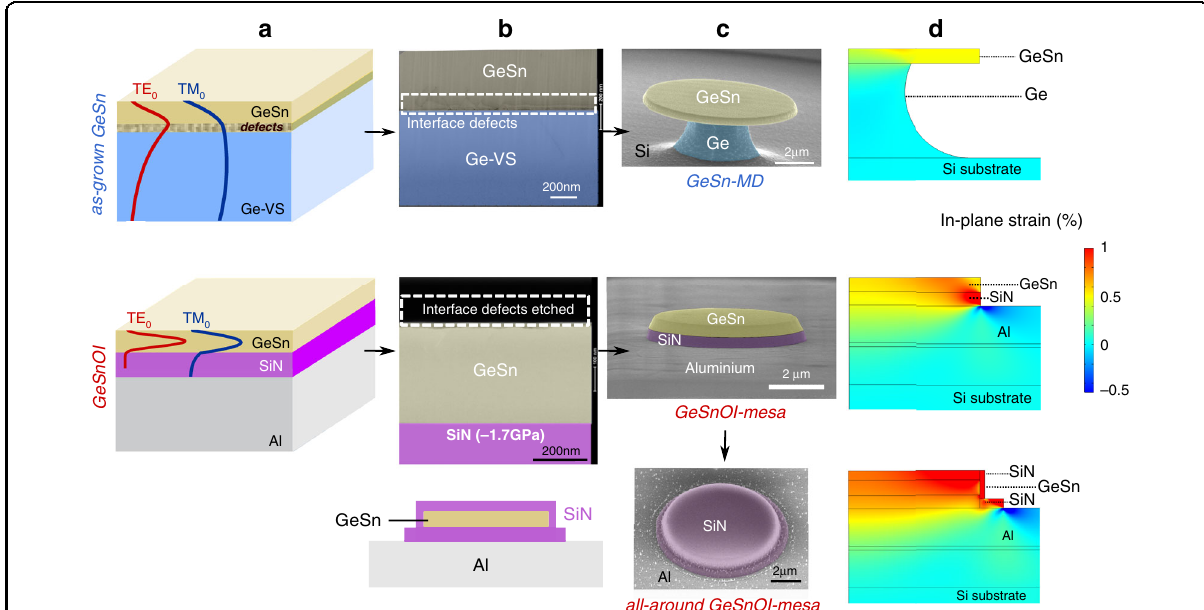
Fig. 1 Design and fabrication of GeSnOI planar cavities. a Schematic diagram of as-grown GeSn on Ge SRB and GeSnOI stacks together with TE and TM mode pro fi les of a con fi ned optical wave at a 2.4 µm wavelength. More details are given in the SI (Fig. S3). b X-TEM images of as-grown GeSn on Ge SRB and of GeSnOI stacks. c Scanning electron microscopy (SEM) images of GeSn and GeSnOI and all-around strained microdisk cavities. A cross-sectional schematic representation of the GeSnOI mesa fully cladded with SiN can be found on the left of the bottom SEM image ( d ) in-plane strain variation, analyzed by Finite Element modeling (FEM), of GeSn and GeSnOI microdisks with 7 µm diameters that due to the different designs and processing adopted. Here we plot the strain relative to initial residual post-growth compressive strain of − 0.5% for the GeSn layer. The SiN layer was computed with initial compressive stress that can relax, thus inducing positive strain variation